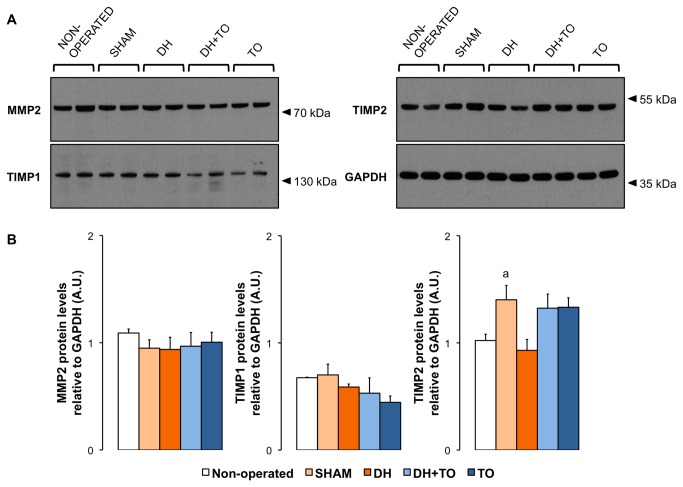
Protein expression levels of MMPs and TIMPs in lung tissue homogenates in the fetal rabbit model for CDH undergoing TO.
A. Representative Western blot detection for MMP2, TIMP1, and TIMP2 in non-operated, SHAM, DH, DH+ TO, and TO groups. GAPDH was used as loading control. Western blot analyses revealed the latent form of MMP2 (72 kDa) and high-molecular weight complexes for TIMP1 (130 kDa) and TIMP2 (54 kDa). Two representative samples for each group are depicted. B. Densitometric analysis showing that TIMP2 dimeric complex was upregulated in the lung of SHAM fetuses as compared to non-operated fetuses. Values and error bars illustrate mean and standard error of the mean obtained from non-operated (n = 4), SHAM (n = 4), DH (n = 3), DH+ TO (n = 4), and TO groups (n = 4). One-way ANOVA with Bonferroni correction was used for comparisons between surgical groups (SHAM, DH, DH+ TO, and TO) and unpaired Student’s t-test for comparisons between non-operated and SHAM fetuses. SHAM, sham-operated fetuses; DH, diaphragmatic hernia fetuses; DH+ TO, DH fetuses with tracheal occlusion; TO, sham DH fetuses with TO. a
P < 0.05 vs non-operated. A.U. = arbitrary unit.